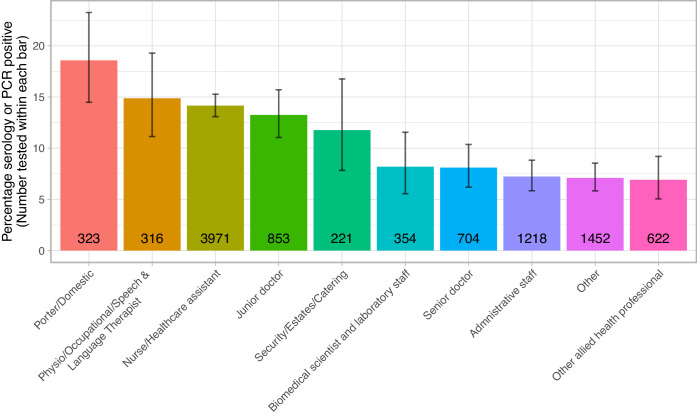
Proportion of staff testing positive by role.The number of staff tested within each role is shown within each bar. The error bar indicates the 95% confidence interval.